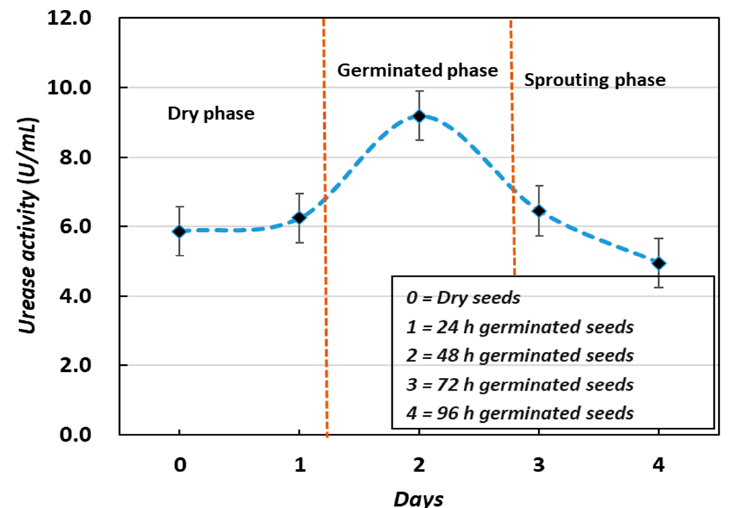
Figure 4. Urease activity of different conditions of seed.